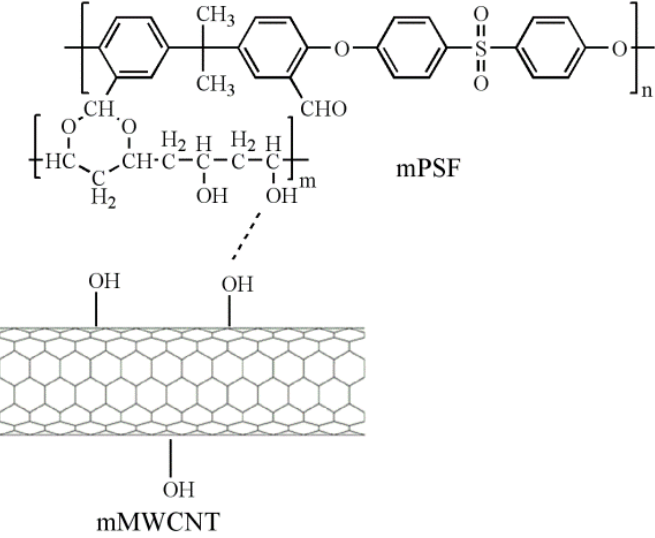
Figure 1. Structure of mPSF/mMWCNTs composite.